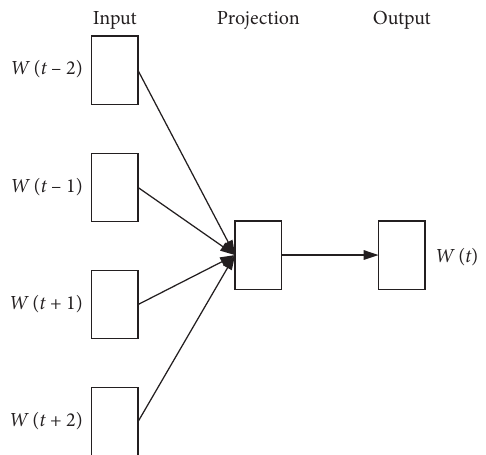
Figure 2: Schematic diagram of CBOW model